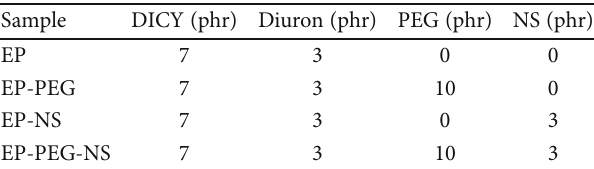
Table 2: Details of composition of the formulations. Sample